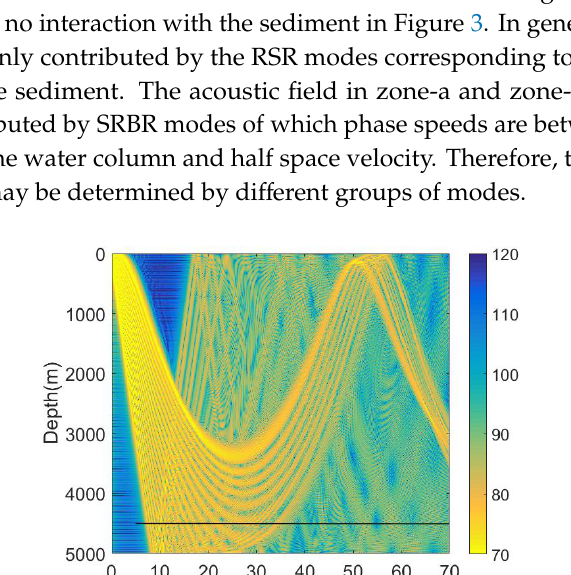
Figure 2. Intensity versus range and frequency. The intensity is divided into three parts, such as zone-a, zone-b, and zone-c, according to artificial observation.